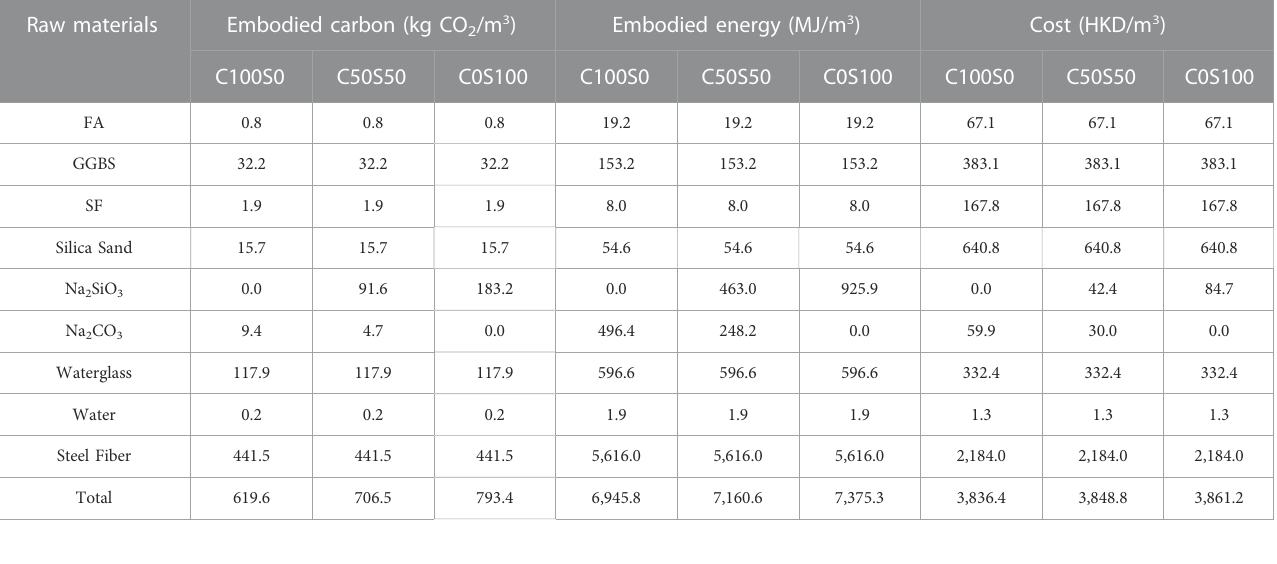
TABLE 3 Embodied carbon, embodied energy, and cost of SH-UHPGC.